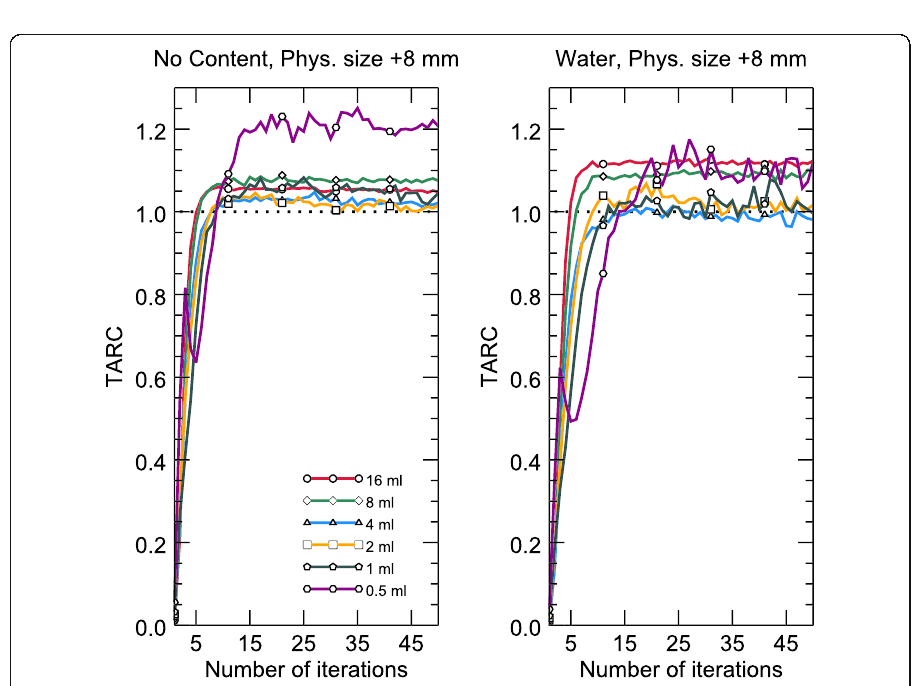
Fig. 3 TARCs for spherical VOIs with diameters equal to the physical diameter plus 8 mm (the length of two voxel sides). The results are shown for iterations 1 – 50 for a set of spheres in the empty (left) and water-filled (right) torsos. Only every fifth data point is marked for clarity. The TARCs rise initially, up to 10 – 15 iterations and remained constant up to 100 iterations, but only the initial 50 iterations are shown